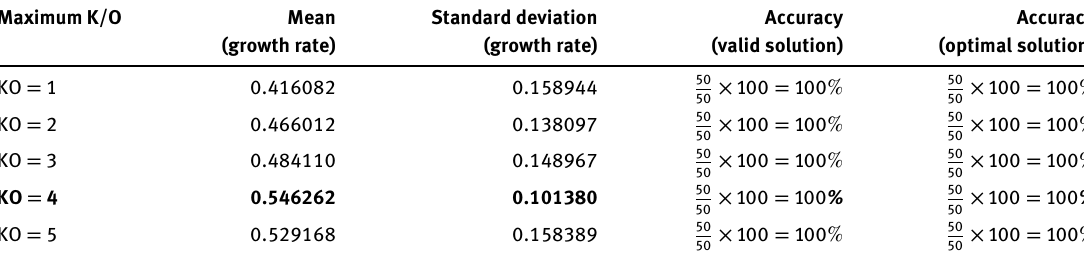
Table 5: Performance measurement of succinate production.